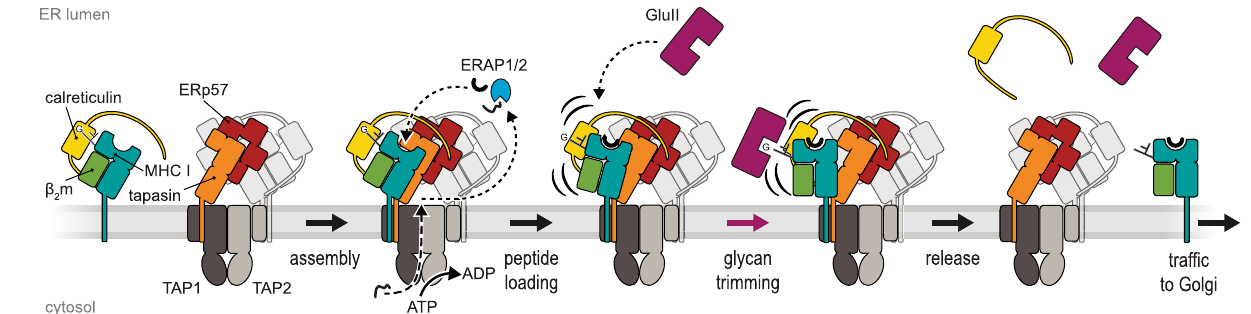
Fig. 5 | Mechanism of MHC I assembly, peptide editing, and quality control. Peptide-receptive MHCIheterodimersare recruited by calreticulinto the PLC and form the fully assembled PLC, which is composed of two editing modules. The peptide transporter TAP1/2 shuttles peptides from the cytosol into a molecular basket formed by the editing modules. Two lateral windows allow peptides to diffuse intothe ER lumentobe edited bythe ER-residentaminopeptidase ERAP1/2 and subsequently loaded onto MHC I molecules. After tapasin-facilitated peptide